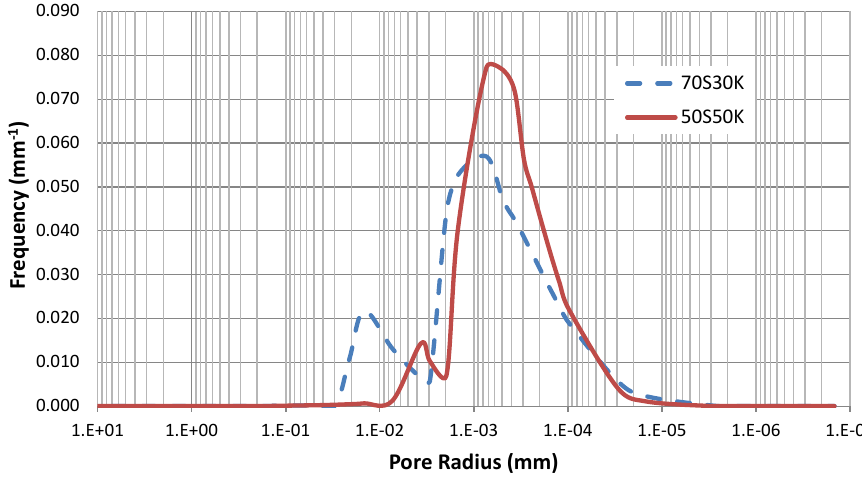
Figure 7. Pore-size distribution curve of 70S30K and 50S50K.